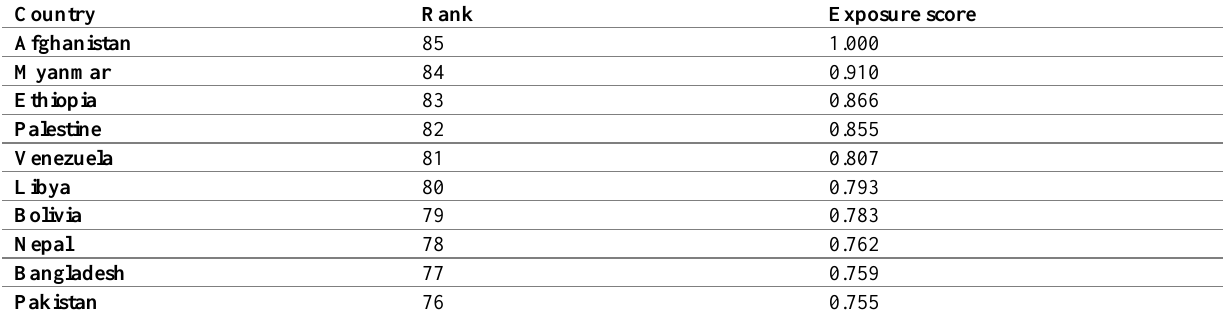
Table 2: The most exposed countries to cybercrime